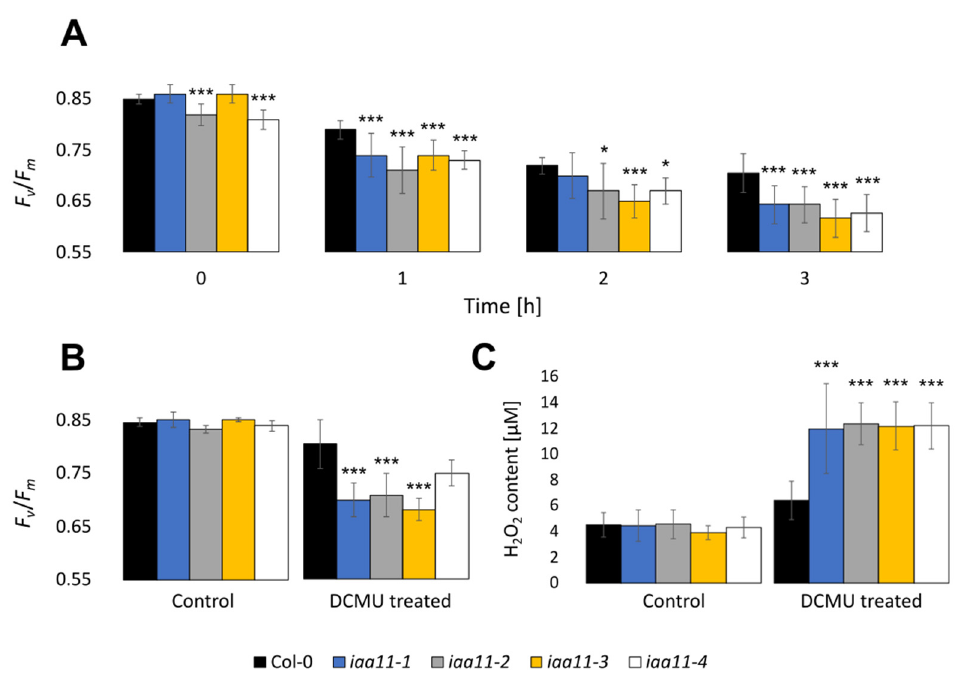
Figure 4. 3-(3,4-dichlorophenyl)-1,1-dimethylurea (DCMU) susceptibility of Aux/IAA11 mutants. ( A ) Maximum quantum efficiency of photosystem II ( F v / F m ) after 0, 1, 2, and 3 h of 60 µ M DCMU treatment (n = 9). ( B ) F v / F m and ( C ) H 2 O 2 content measured after 15 min of 200 µ M DCMU treatment. n ≥ 6, Dunnett’s test (* p < 0.05; *** p < 0.001). Error bars represent the standard